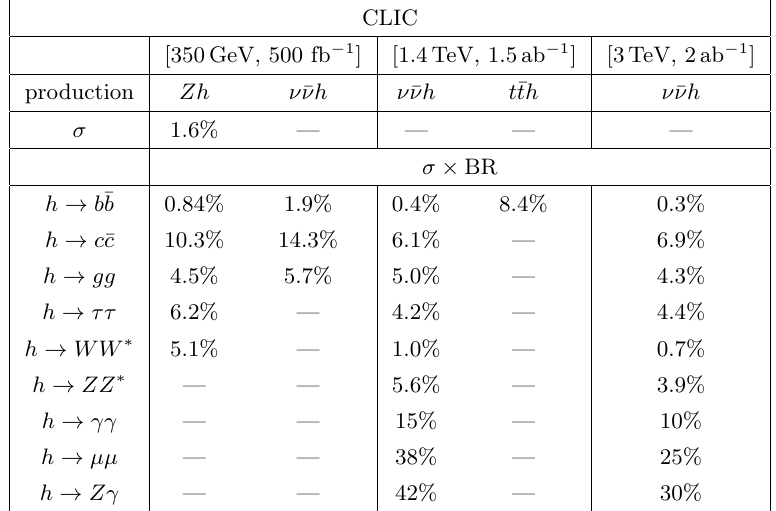
Table 4 . The estimated precision of CLIC Higgs measurements taken from ref. [60], which assumes unpolarized beams and considers only statistical uncertainties. In addition, we also include the estimations for (cid:27) ( hZ ) BR( h b (cid:22) b ) at high energies in ref. [35], which are 3.3% (6.8%) at 1.4 TeV (cid:2) ! + e (3 TeV). We (cid:12)nd the inclusion of the ZZ fusion ( e + e ) measurements to have little (cid:0) ! e (cid:0) h impact in our analysis.